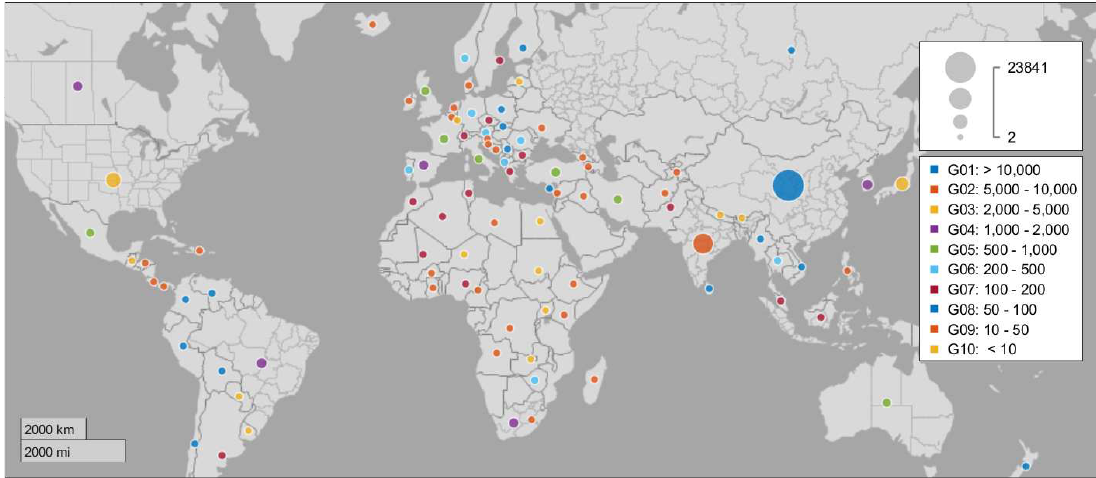
Figure 1. Global distribution of large dams as of